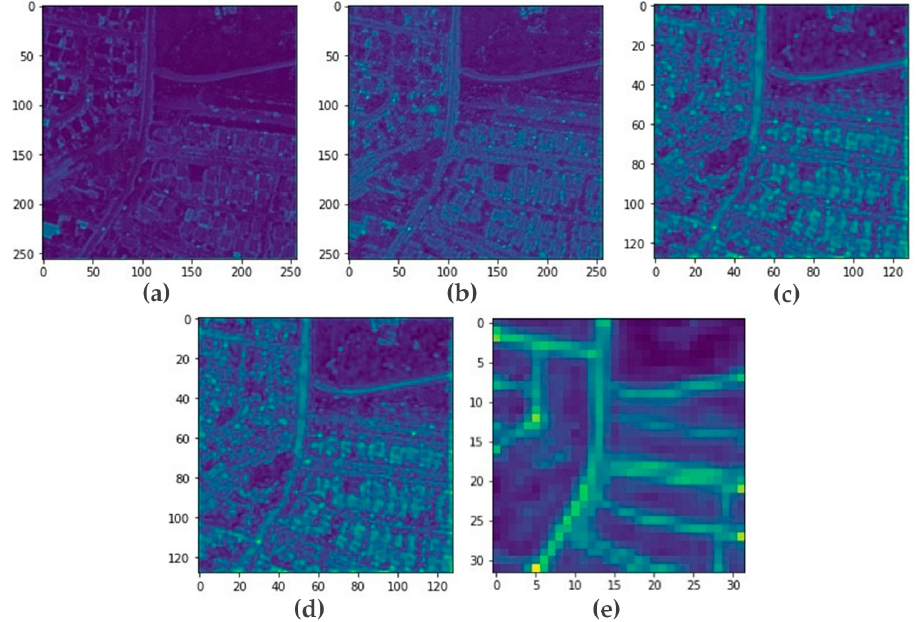
Figure 11. The visualization of features at each stage. ( a ) First stage visualization; ( b ) second stage visualization; ( c ) third stage visualization; ( d ) fourth stage visualization; ( e ) fifth stage visualization.